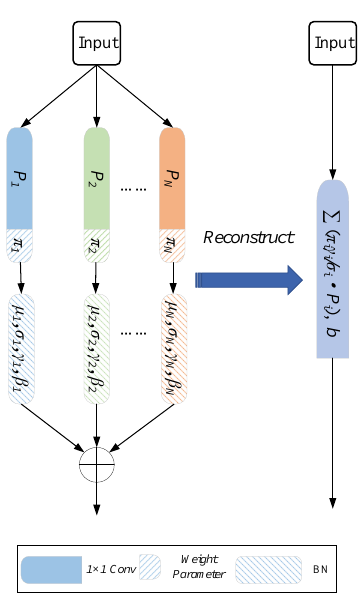
Figure 2. Structural reconstruction of a